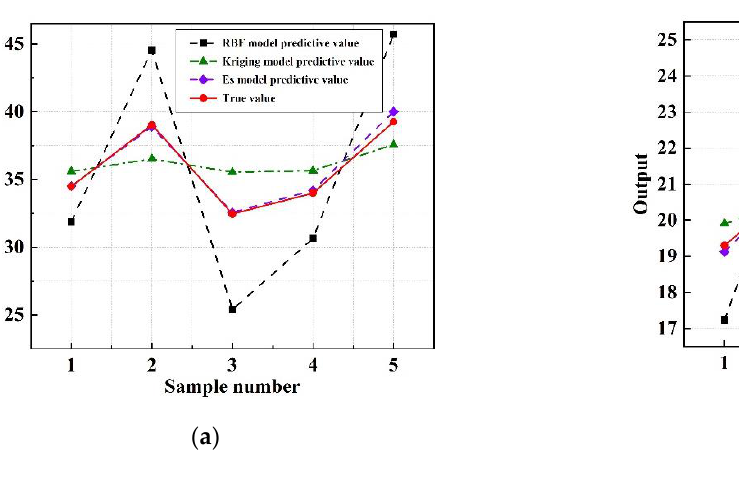
Figure 10. Prediction error of each model test set. ( a ) Efficiency prediction error of each model. ( b ) Flow prediction error of each model.